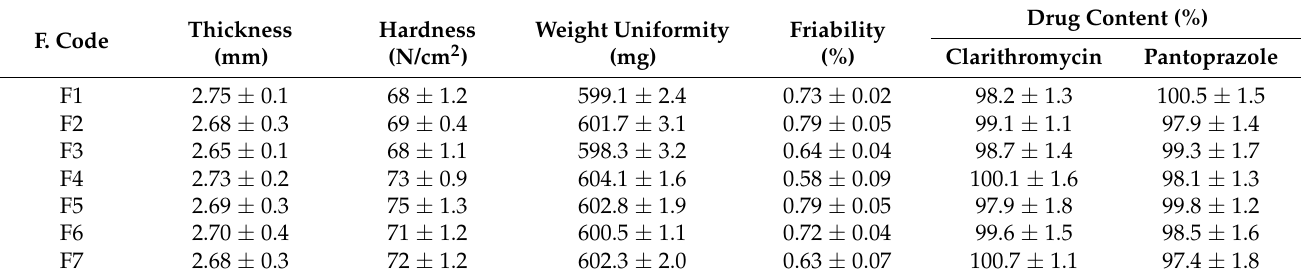
Table 2. Post-compression tests of the formulated